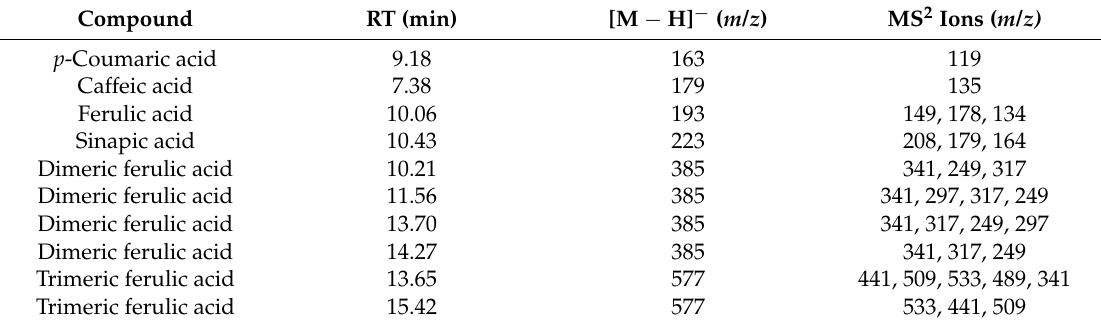
Table 2. Mass spectral characteristics of phenolic compounds identified in bread samples.